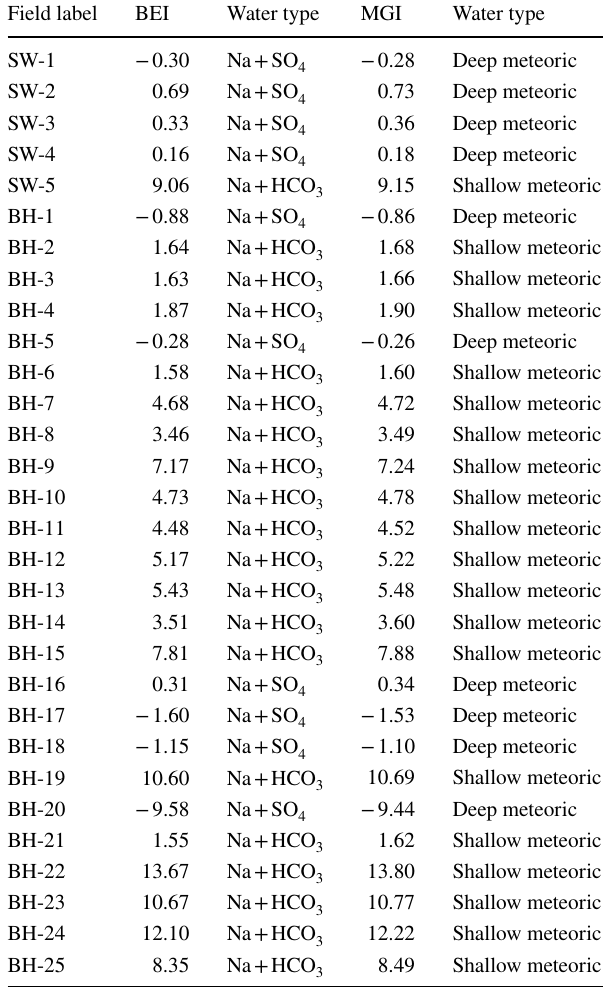
SW surface water, BH bore